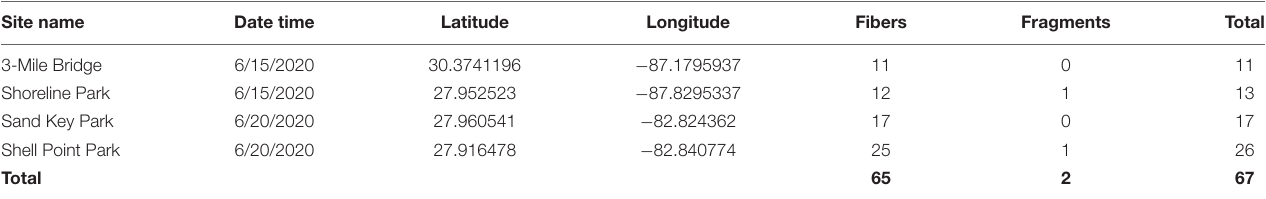
FIGURE 1 | Map showing collection sites and major location of seawater samples and snail tissues as well as the quantity of microplastics from both seawater samples and snail tissue samples. Collection sites Shoreline Park and 3-Mile Bridge are at the major location Northwest Panhandle Florida and collection sites Shell Point Park and Sand Key Park are at the major location Central Florida. Size of each pie graph is correlated to the number of microplastics counted. Both seawater and snail microplastic counts for both microfibers and microfragments and are indicated by colors labeled in the key (RS, Stramonita haemastoma ; CC, Melongena corona ). TABLE 1 | Microplastics identified for seawater samples for 2 L of